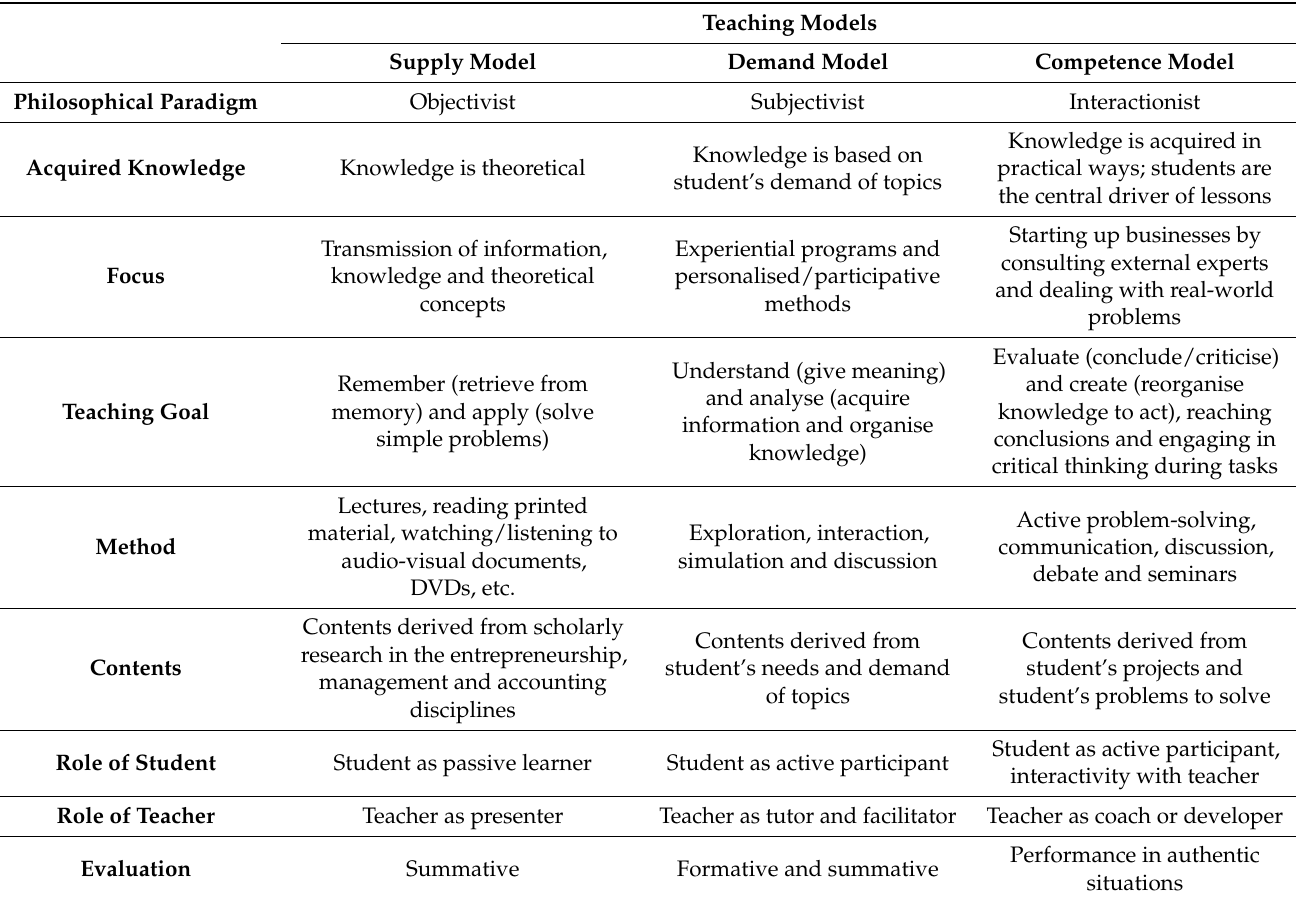
Table 1. Teaching models framework adapted from B é chard and Gr é goire’s (2005) analytical